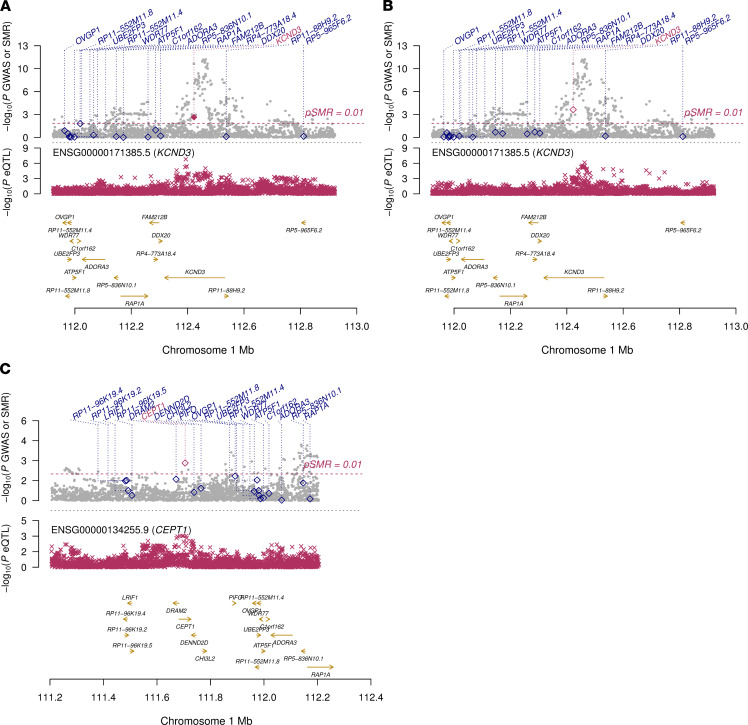
Colocalization results.Illustrations of the SMR test for the early repolarization pattern (ERP) risk and the expression quantitative trait loci (eQTLs) at the rs1545300 locus at chromosome 1p13.2 for the (A) left ventricle of the heart, (B) tibial artery, and (C) minor salivary gland tissue. The sample sizes for the eQTLs are n = 272, n = 388, and n = 85 in A, B, and C, respectively. In A–C, the GWAS regional association plot with ERP risk of the combined GWAS (n = 39,456), with level of significance of the SMR test (y axis) for each transcript in the locus indicated by a diamond positioned at the center of the transcript is shown (top). A significant SMR test represented by a purple diamond indicates an association of the transcript level of the respective genes (purple label) with the trait. For all 3 tissues, an increased gene expression level shown by a significant SMR test was associated with a higher risk of ERP. A filled purple diamond indicates a HEIDI test P > 0.05 and, thus, a likely colocalization. The regional association distribution with changes in expression of the highlighted (purple) gene transcript in the respective tissue is shown below. The x axis shows GRCh37/hg19 genomic coordinates throughout.